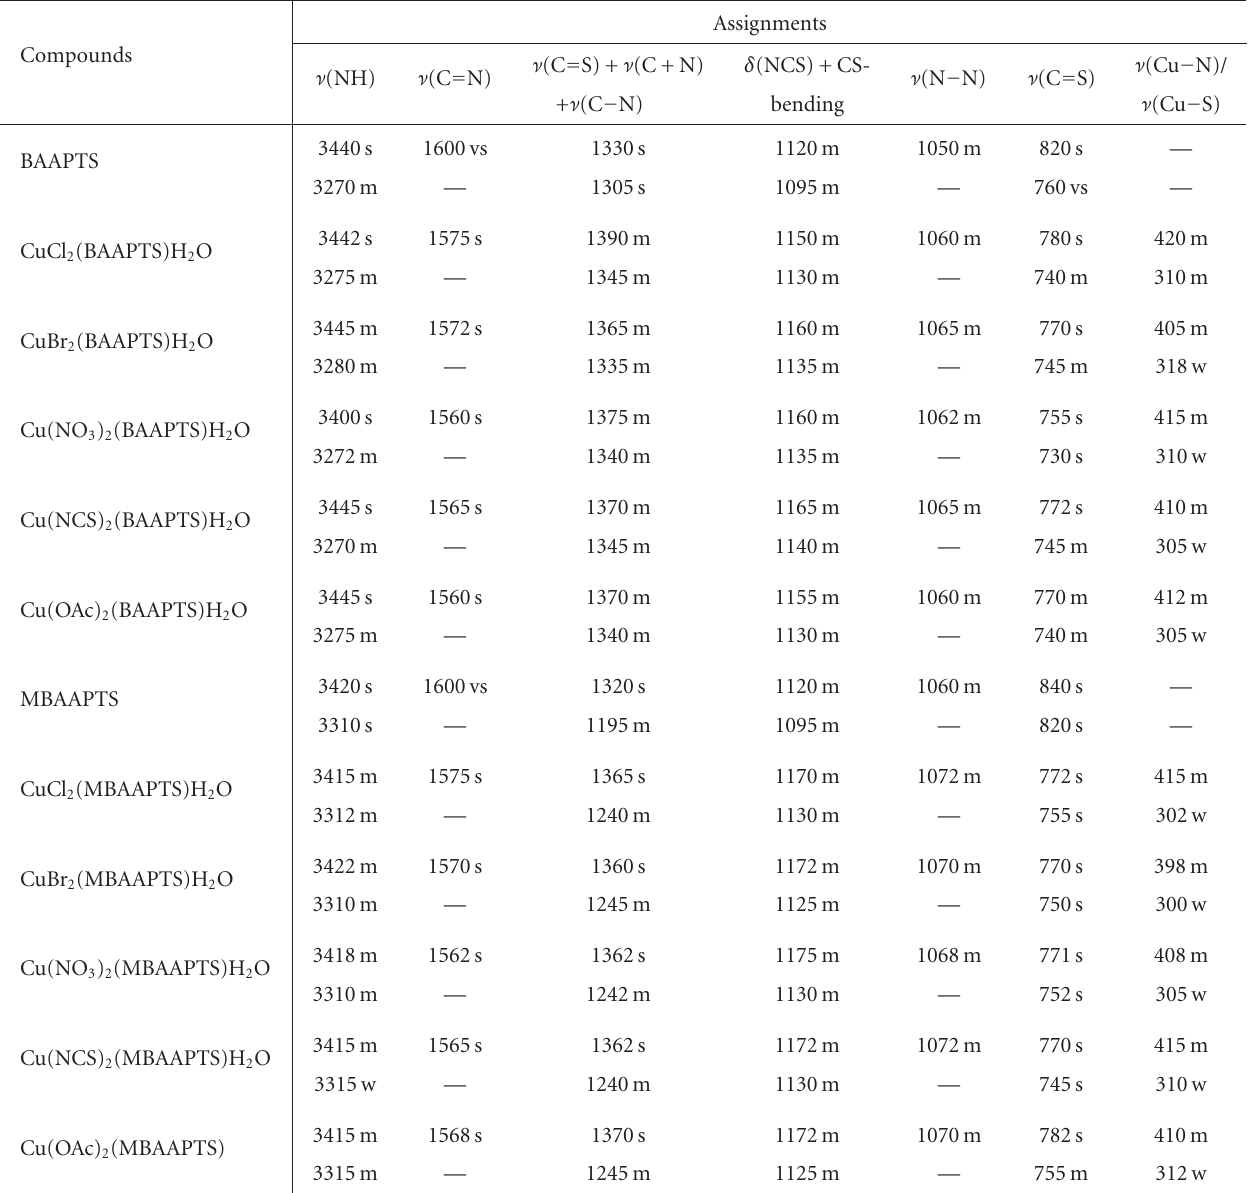
Table 3: Key IR bands (cm − 1 ) of BAAPTS and MBAAPTS and their Cu 2+